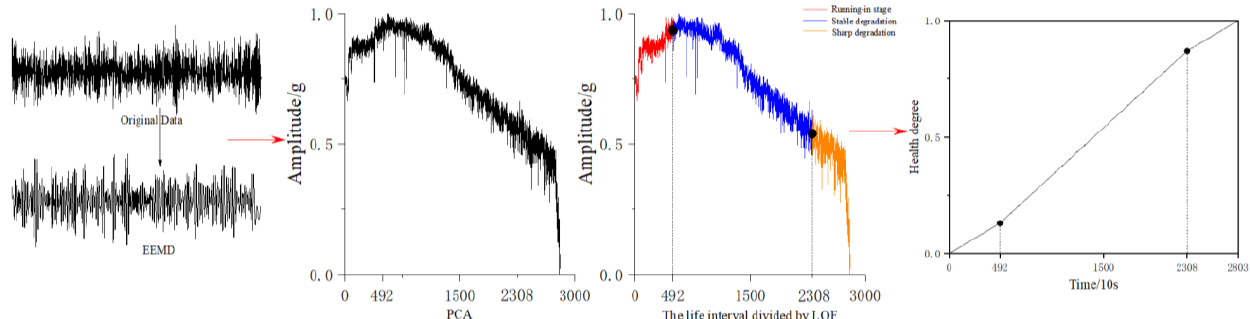
Figure 11. Data processing process.